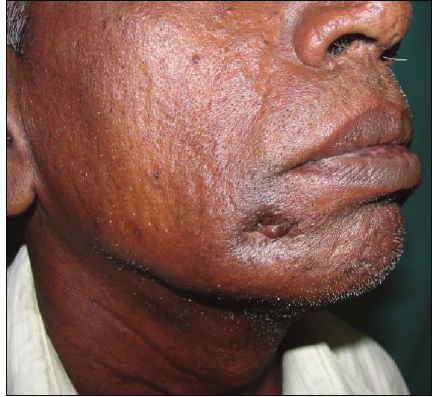
Figure 2: Sinus opening on right side of the face.